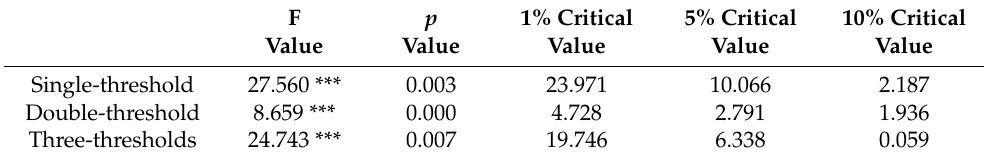
Table 5. Threshold effect test: From the perspective of green innovation factor output.